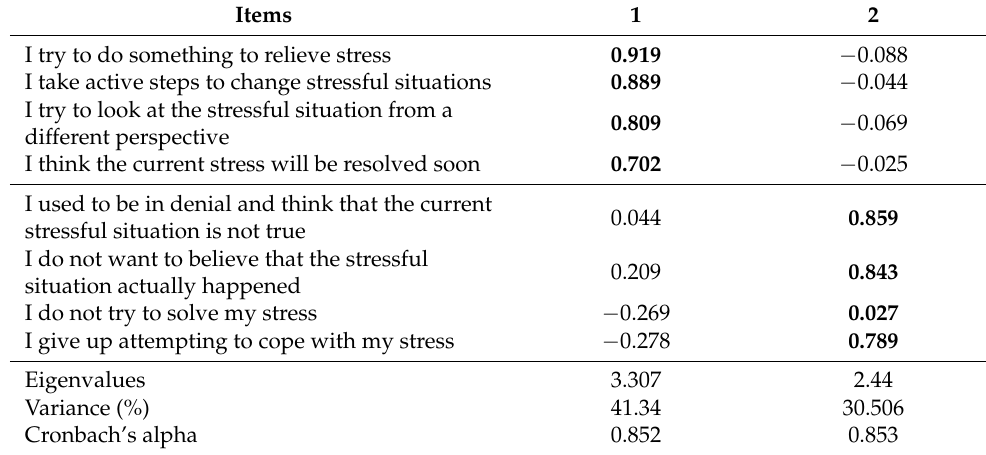
Table 3. Factor structure matrix for stress